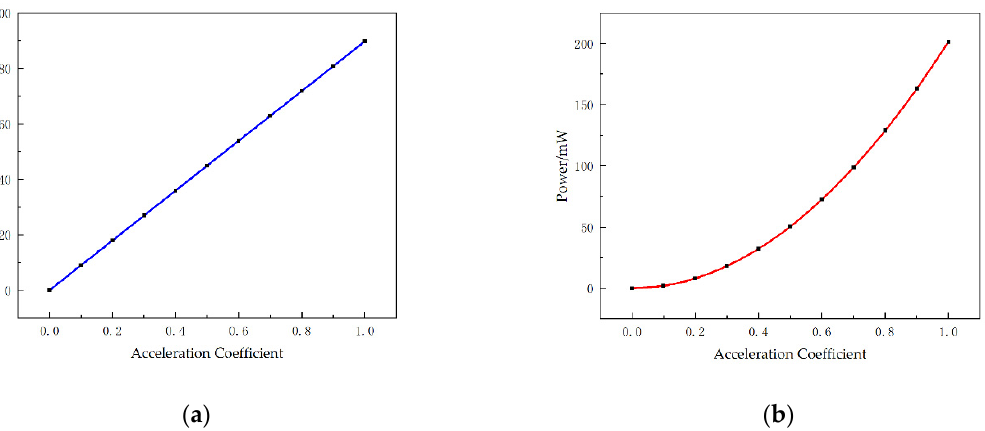
Figure 5. Output performance of the STTM-PEH with a varying acceleration coefficient. ( a ) Output